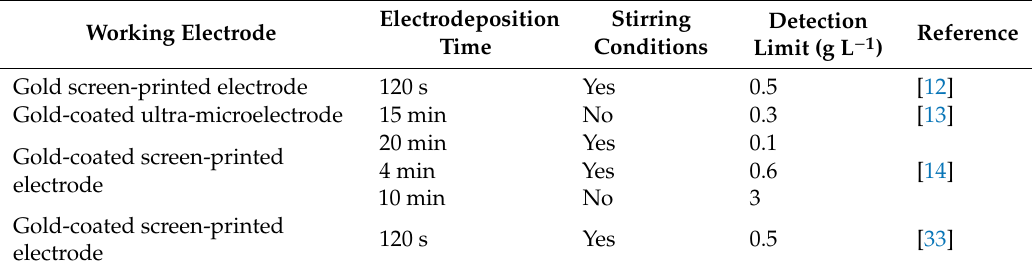
Table 2. Selected examples of gold working electrodes for lead